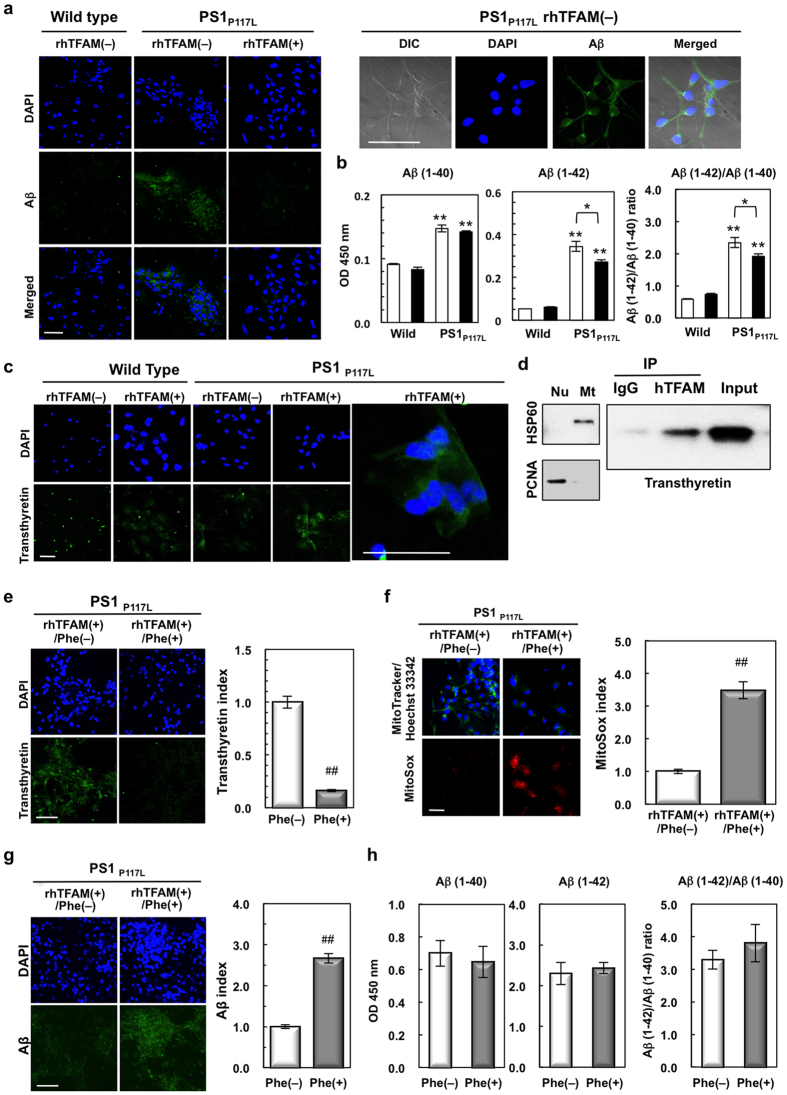
Recombinant human TFAM inhibits Aβ accumulation in a human neuron model of AD with increased expression of transthyretin.(a) rhTFAM decreases the accumulation of Aβ in PS1P117L cells. Wild-type and PS1P117L cells were treated with (rhTFAM[+]) or without rhTFAM (rhTFAM[-]) for 24 h. (b) rhTFAM has little effect on Aβ secretion in PS1P117L cells. Secretion of Aβ(1–40) and Aβ(1–42) was measured by ELISA using the supernatant 24 h after the treatment of 100 nM ΔMTS_rhTFAM (open bars) or rhTFAM (closed bars) protein. Means ± SEM, n = 4. Two-way ANOVA, p < 0.0001. Tukey’s HSD test, **p < 0.0001 vs. wild-type cells (wild) with or without treatment. *p < 0.05. (c) rhTFAM increases transthyretin expression in PS1P117L but not in wild-type neurons. (d) Interaction of transthyretin and rhTFAM in mitochondria of PS1P117L cells treated with rhTFAM. PS1P117L cells were treated with 100 nM rhTFAM for 24 h and then fractionated into mitochondrial (Mt) and nuclear (Nu) fractions (left panels). Proliferating nuclear antigen (PCNA, 35.5 kDa) or heat shock protein 60 (HSP60, 60 kDa) was detected as a nuclear or mitochondrial marker, respectively. Co-immunoprecipitation of transthyretin was performed using anti-hTFAM or normal IgG as a negative control (IgG) and the mitochondrial fraction prepared from PS1P117L cells treated with rhTFAM (right panels). (e) Phenylalanine significantly decreased expression of transthyretin in rhTFAM-treated PS1P117L cells. Cells were treated with 100 nM rhTFAM in the presence (Phe[+]) or absence (Phe[–]) of phenylalanine. Transthyretin index is shown in the bar graph. Student’s t-test, ##p < 0.0001. (f) Phenylalanine increased ROS production in rhTFAM-treated PS1P117L cells. Student’s t-test, ##p < 0.0001. (g) Phenylalanine increased Aβ immunofluorescence in rhTFAM-treated PS1P117L cells. Aβ index is shown in the bar graph. Student’s t-test, ##p < 0.0001. Data represent means ± SEM from 50 cells. (h) Phenylalanine did not alter Aβ secretion in rhTFAM-treated PS1P117L cells. No significant alteration was observed for the Aβ (1–42)/Aβ (1–40) ratio or the level of each Aβ peptide. Data represent means ± SD, n = 3. All scale bars (a,c,e,f,g), 40 μm.